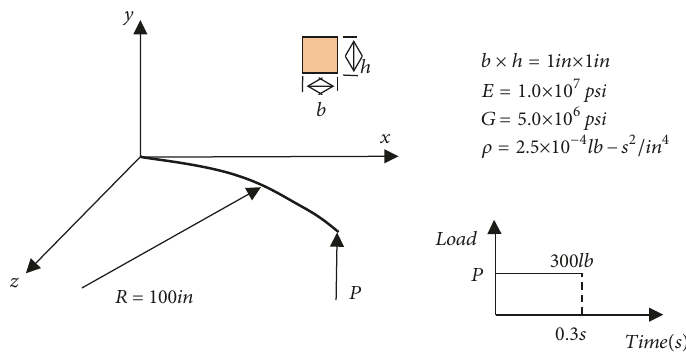
Figure 9: Space cantilever curved beam.